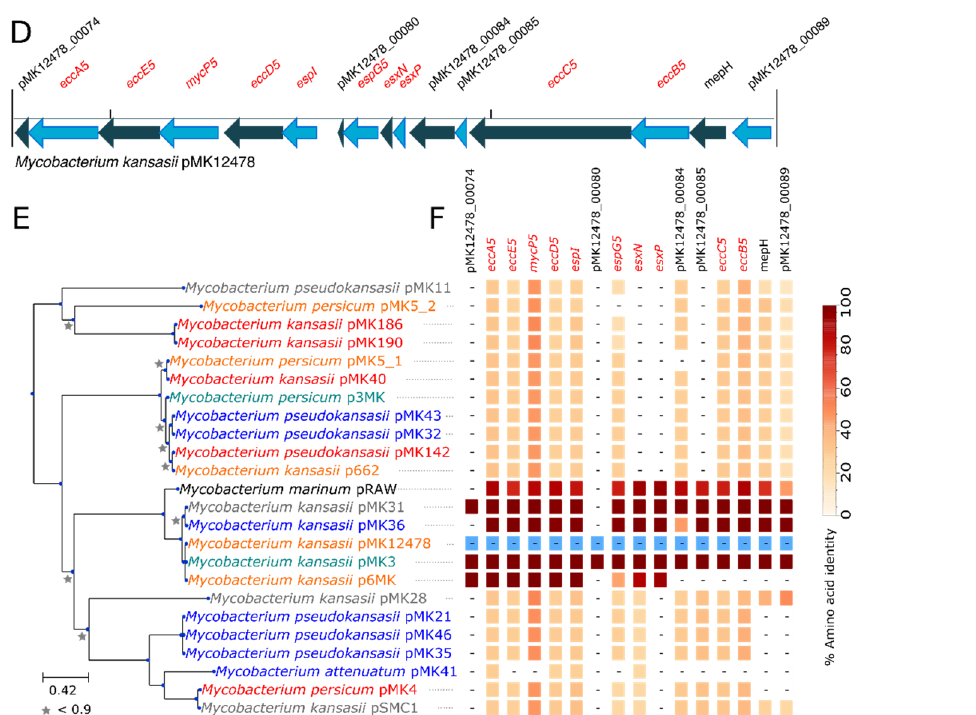
Figure 5. Distribution of the conjugative plasmids detected in the M. kansasii complex. ( A ) The type-IV secretion system locus (in blue), as well as the relaxase ( traI ) of the reference conjugative plasmid of M. marinum pRAW (as described in Ummels et al. [31]), is conserved ( C ) in some members of the M. kansasii complex. For multiple-copy orthologous groups, the amino acid identity of the best hit is shown. The reference sequences used to build this plot are indicated in blue. ( D ) Schematic representation of the plasmid-encoded Type-VII secretion system of strain ATCC 12478 and its gene conservation ( F ) in members of the M. kansasii complex. ( B , E ) Maximum-likelihood phylogeny based on the concatenated alignment of six single-copy orthologous genes (2766 amino acids) of the plasmid dataset. Bootstrap values below 0.9 are indicated with grey stars. The colors of the labels indicate pathogenicity, as reported in Table 1. Red = 1 = pathogenic, Orange = 2 = probably pathogenic, Grey = 3 = unknown, Green = 4 = probably non-pathogenic, Blue = 5 = non-pathogenic. Closely related plasmids sharing >99% of amino acid identities were found in different species, indicating probable recent conjugative transfers between species of the